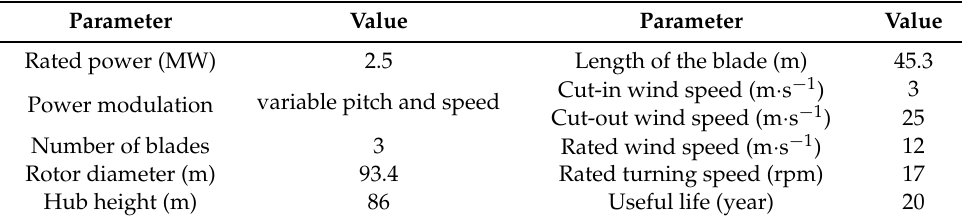
Table 1. The configuration of the FX93-2500 wind turbine.